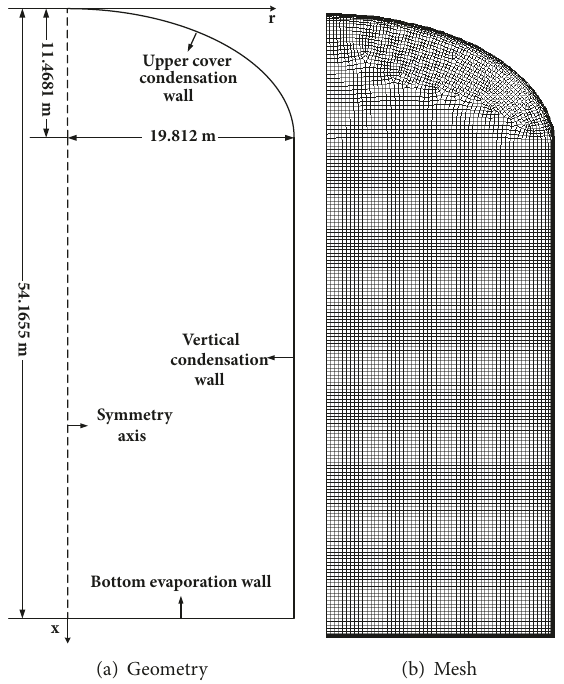
Figure 4: Geometry and mesh of AP1000 containment. (a) Geometry. (b)